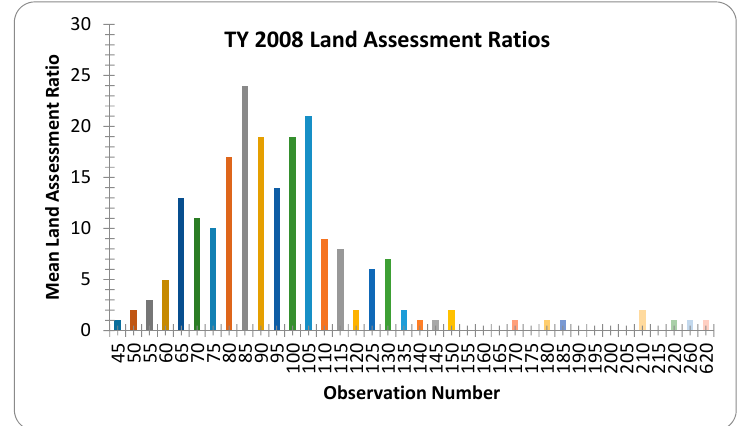
Figure 3. Land assessment ratios for New London in the tax year 2008. The observation number (horizontal axis) is a range, and the Mean Land Assessment Ratio (vertical axis) is the mean overall ratio in the corresponding range. For instance, 45 indicates observations 0 to 45; 50 indicates observations 46 to 50; …; 620 indicates observations 261 to 620.